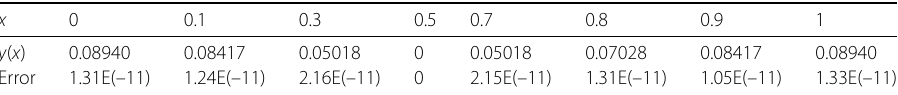
Table 1 For Example 1, showing the numerical solutions and the absolute errors obtained by the BSFM at different points x